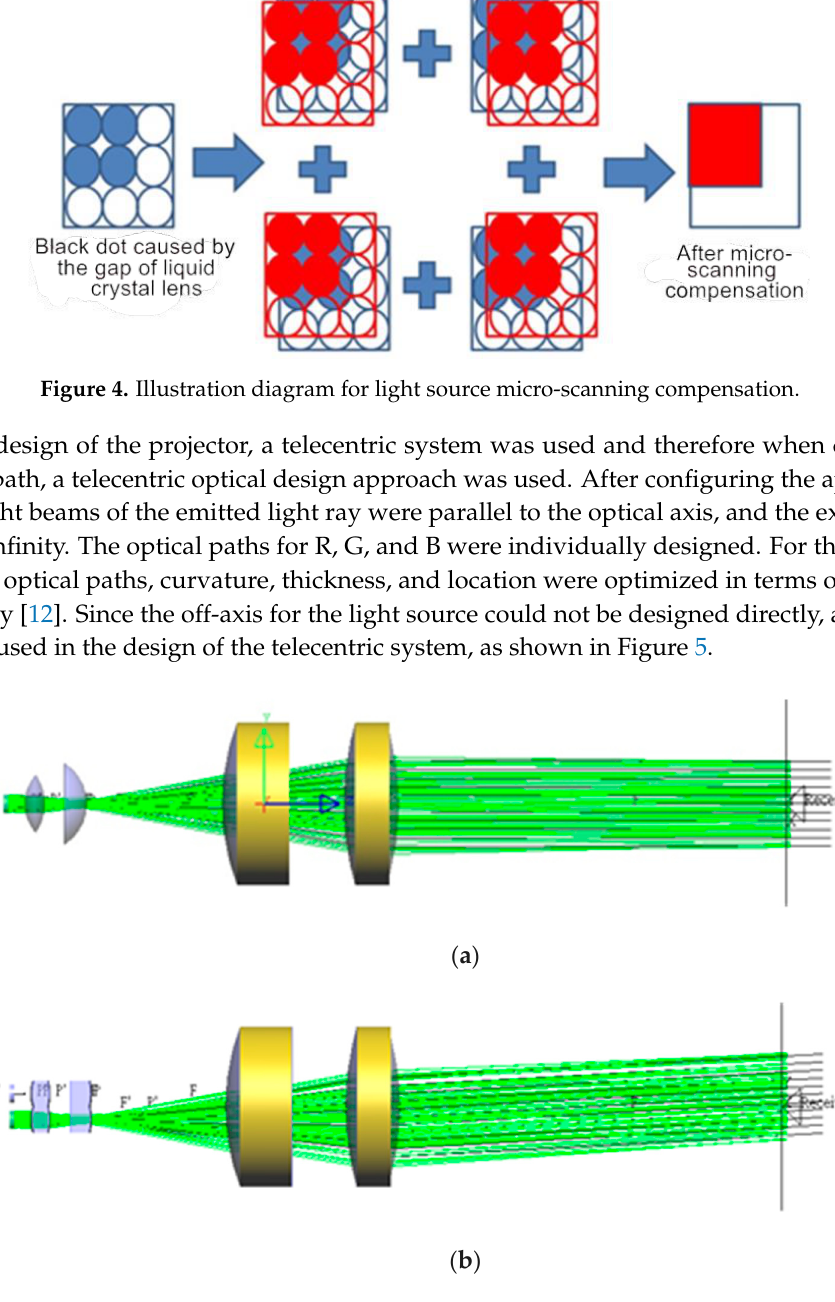
Figure 3. Steps in cycle light source micro-scanning compensation, using the repeating cycle of persistence of human vision.